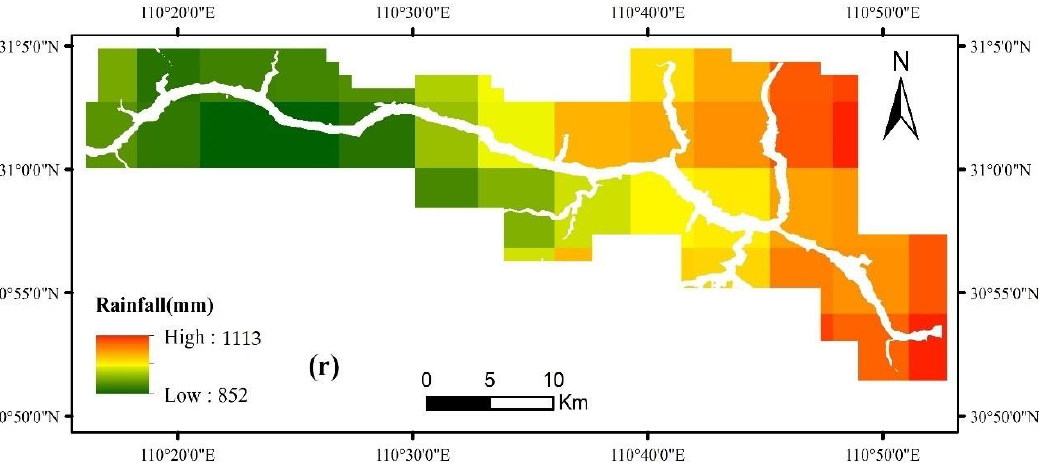
Figure 6. Landslide influence factors: ( a ) vegetation coverage, ( b ) land use, ( c ) elevation, ( d ) slope, ( e ) aspect, ( f ) slope form, ( g ) terrain surface texture, ( h ) terrain ruggedness index, ( i ) topographic curvature, ( j ) bedding structure, ( k ) drainage area, ( l ) flow path length, ( m ) stream power index, ( n ) distance to rivers, ( o ) lithology, ( p ) distance to faults, ( q ) earthquake magnitude, ( r ) rainfall.